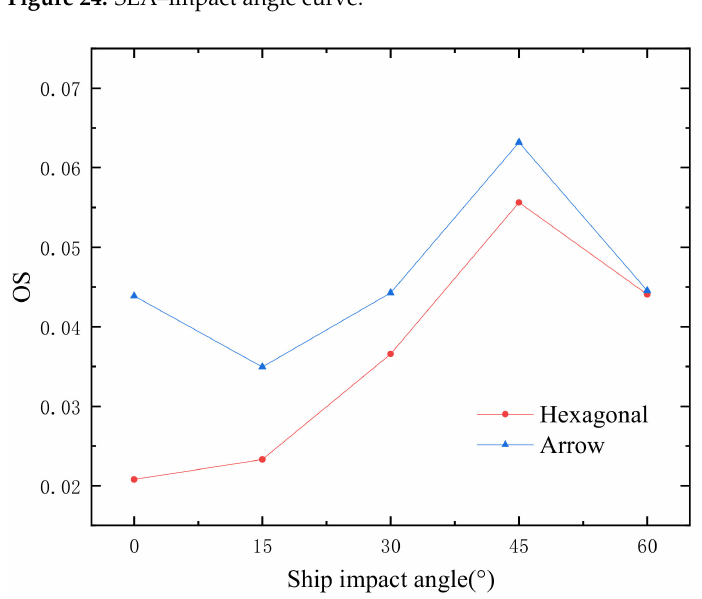
Figure 25. OS–impact angle